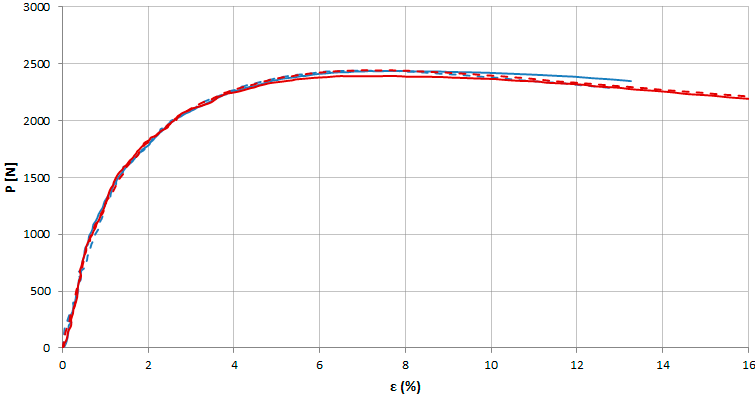
Figure 19. Load–displacement response measured in the biaxial tensile tests (solid curves—horizontal axis; dashed curves—vertical axis).